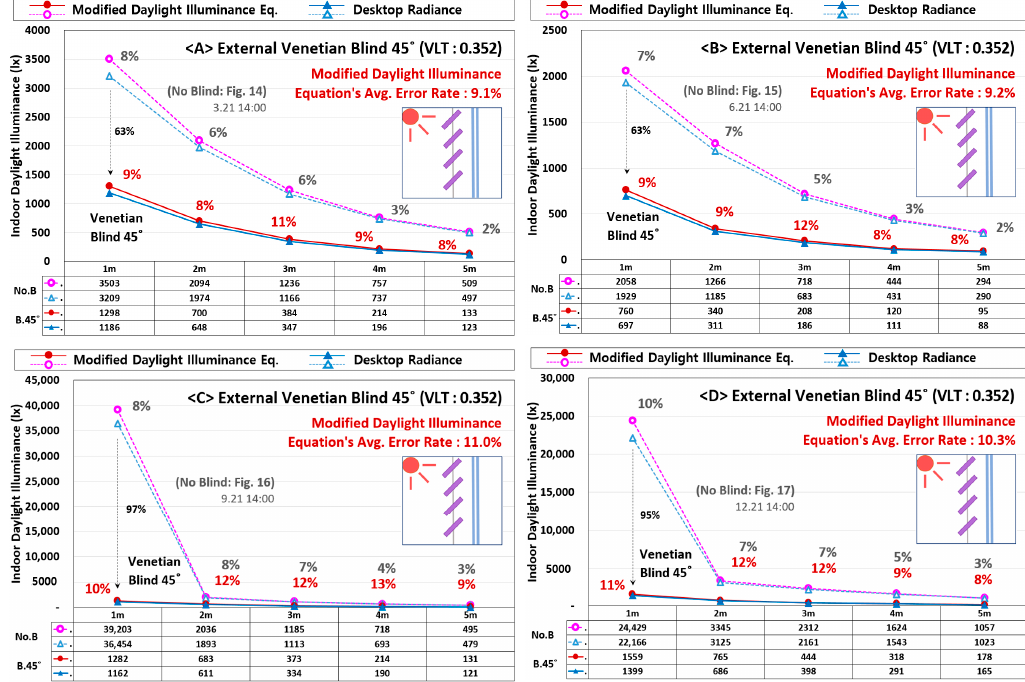
Figure 22. Comparison of indoor illuminance between the modified equation and Desktop Radiance simulation when installing external venetian blind 45° ( A ) 3.21 ( B ) 6.21 ( C ) 9.21 ( D ) 12.21 (14:00).